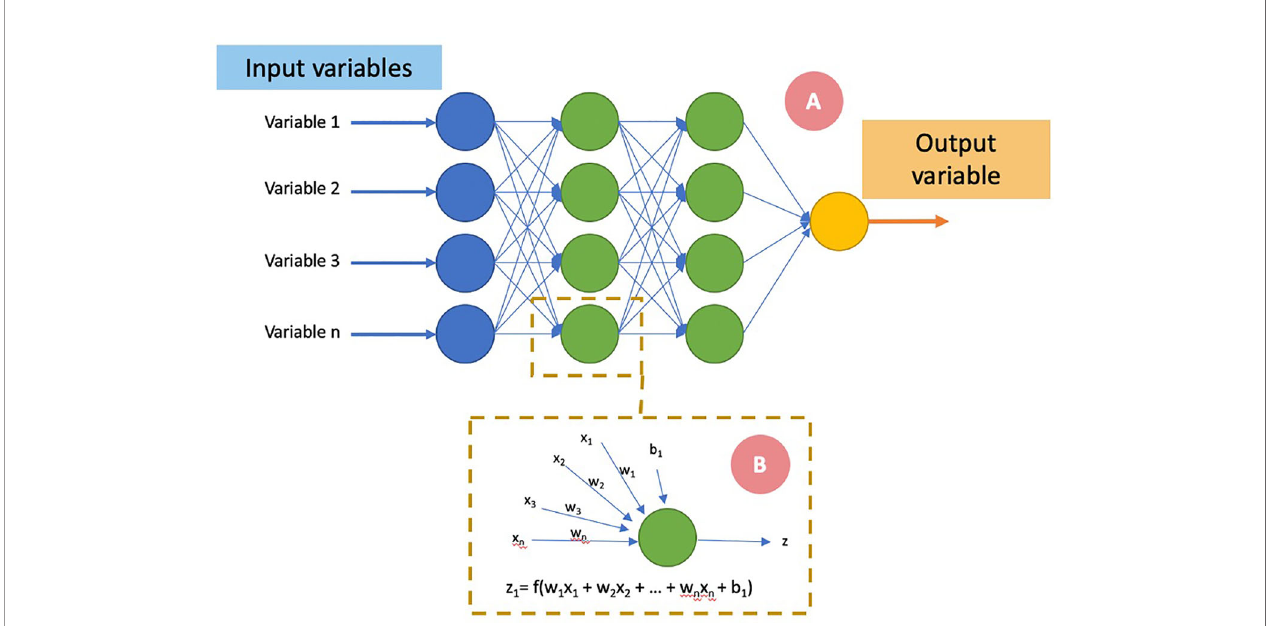
FIGURE 2 | Schematic representation of an arti fi cial neural network. The input variables (A) are presented at the fi rst neural layer (blue). The information is then passed to a succession of layers ( “ hidden layers, ” in green) and fi nally an output neural layer predicting the variable to be estimated. Each layer (i) consists of Ni neurons, taking their inputs from the Ni-1 neurons of the previous layer. A neuron (B) adds each of its inputs (xn) and multiplies them by a weight (wn). An activation function (f) allows according to a threshold the activation of the neuron and the transmission of information (z) to the next layer. An optimizer adjusts the weights and biases (b) of each neuron in order to make the neural network converge toward its state allowing it to make the best